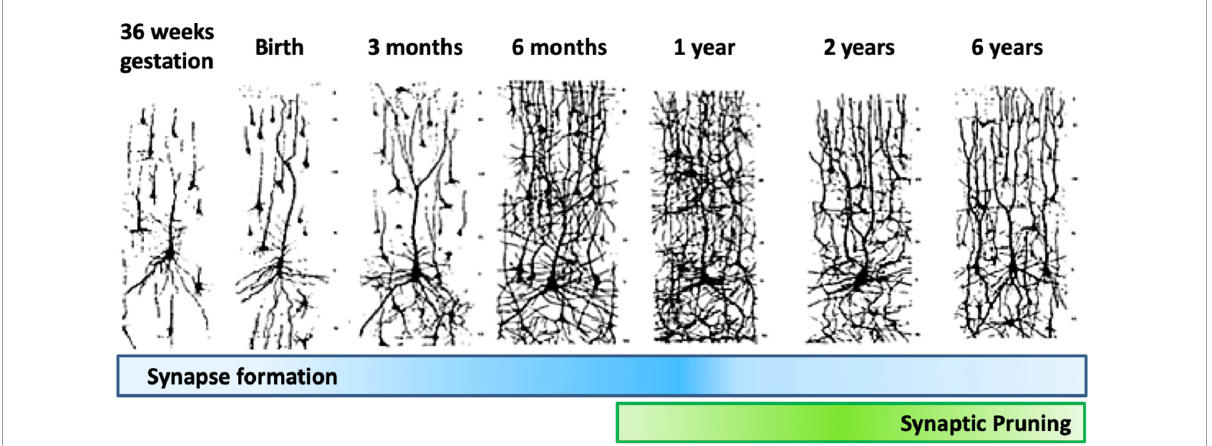
FIGURE10 Synapse formation and pruning in neurotypical development. Starting from birth until adolescence, the synaptic pruning process, preceded by synaptic overgrowth, optimizes the neurological network by removing redundant and weak connections as defined by the learning process, effectively making the brain more efficient. Adults have been found to have approximately 41% fewer neurons than newborns (Abitz et al., 2007). Figure adapted from Conel (1939), obtained by Elsevier (No. 5410821023270) under a creative commons license